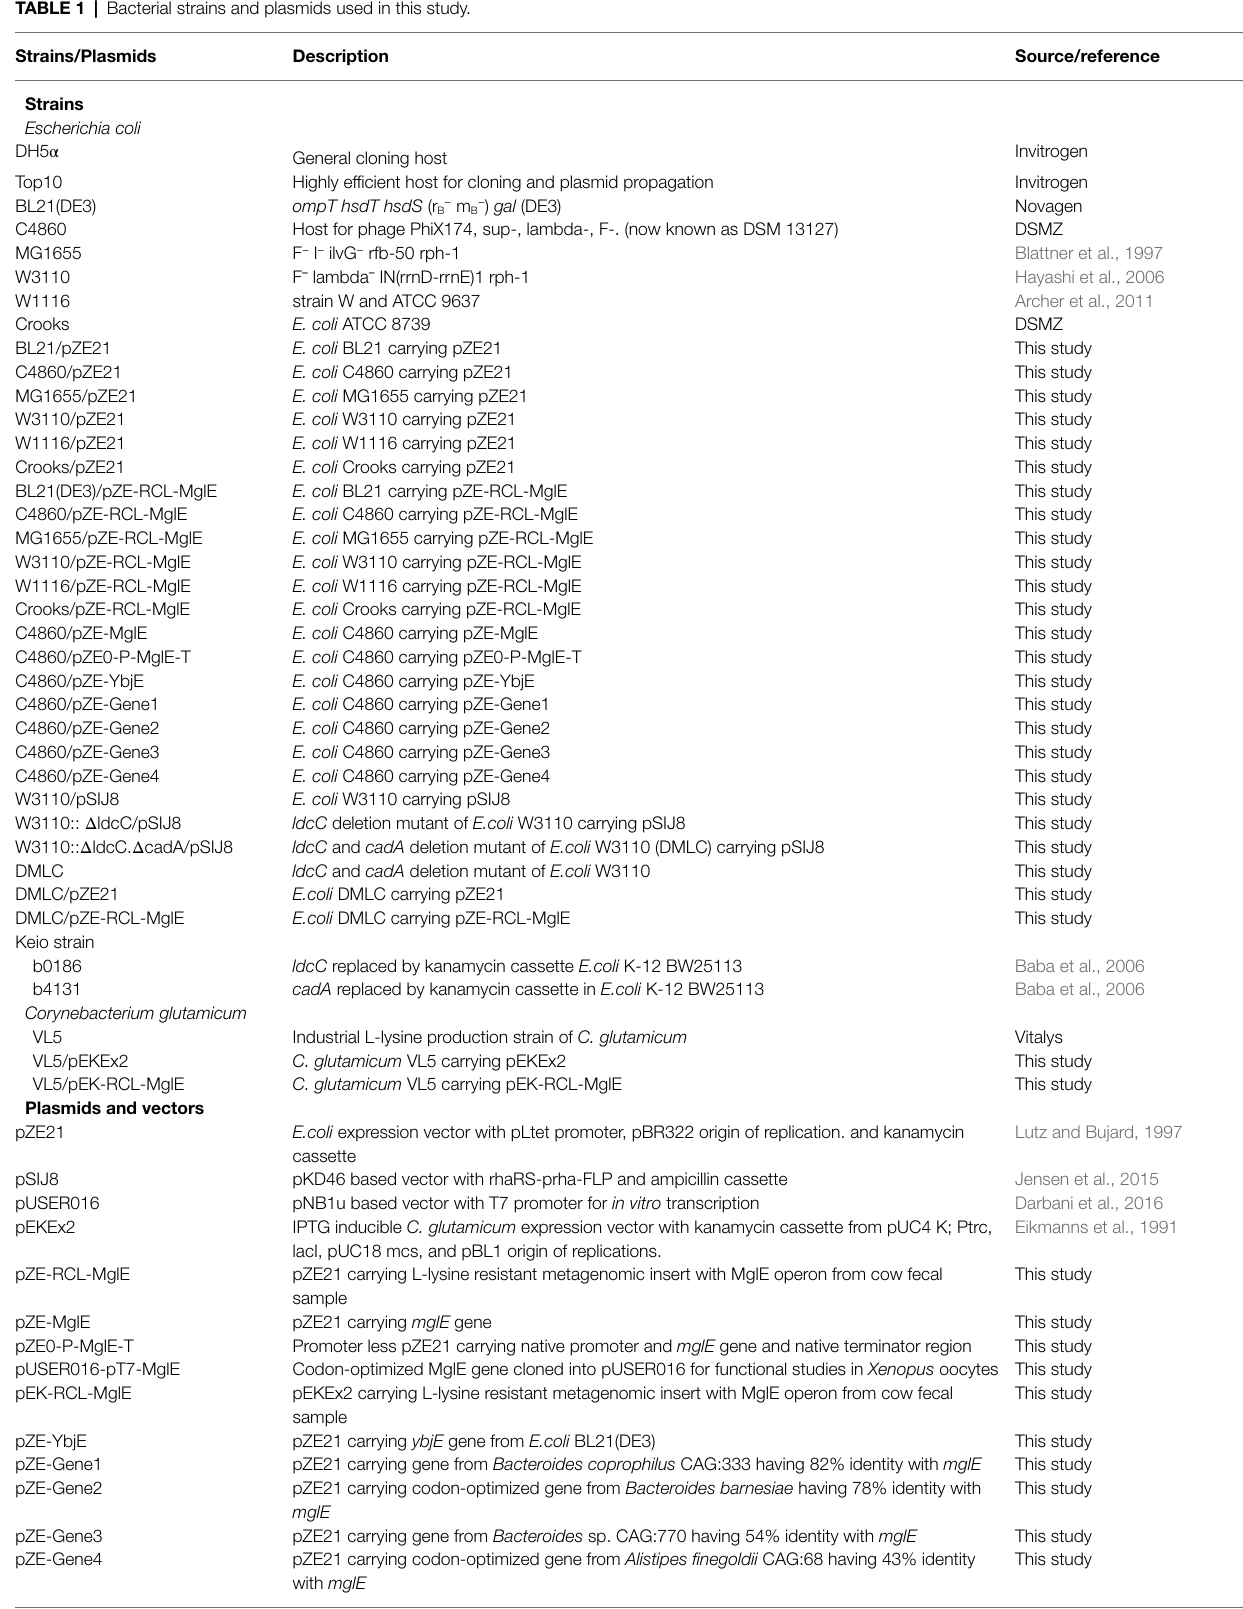
TABLE 1 | Bacterial strains and plasmids used in this study. Strains/Plasmids